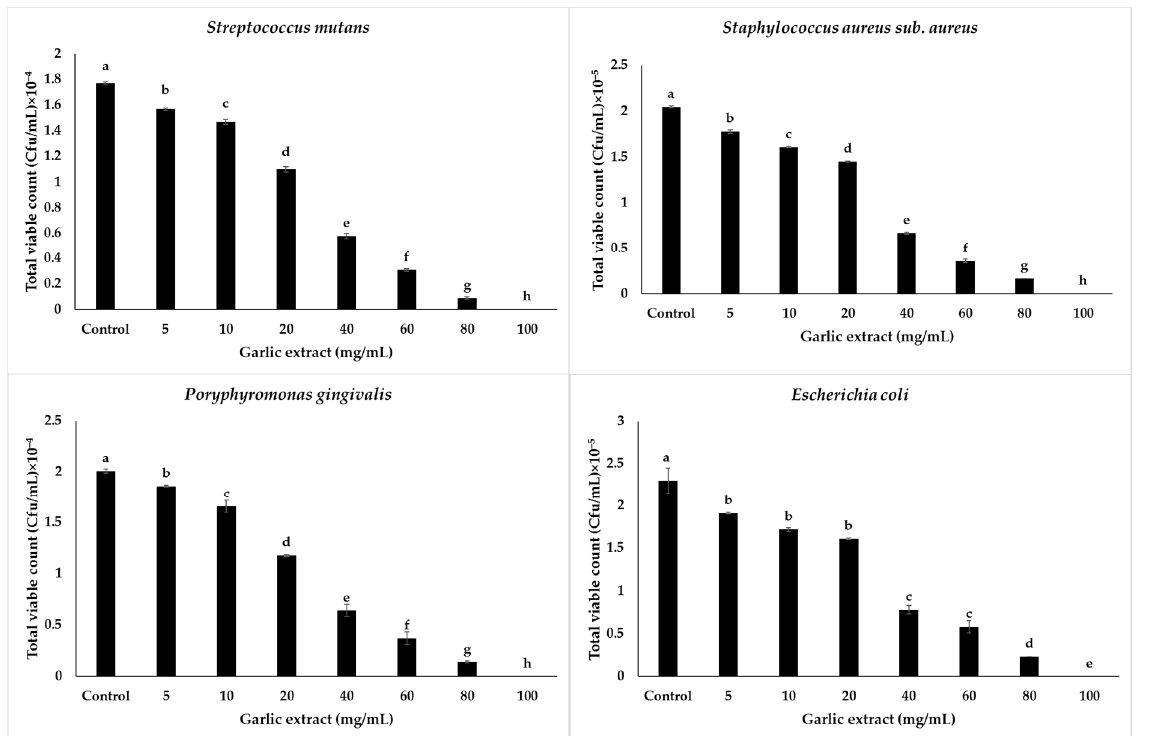
Figure 2. Graphical presentation of antibacterial activity of nanoparticles (supernatant) of garlic ex- tract in terms of total viable counts (CFU/mL) on tested bacteria. Values are means of determinations of three replicates, and bars represent standard deviations (S.Ds.) of the means. S.Ds. followed by different letters are significantly different at p ≤ 0.05 level by Duncan’s multiple range test.